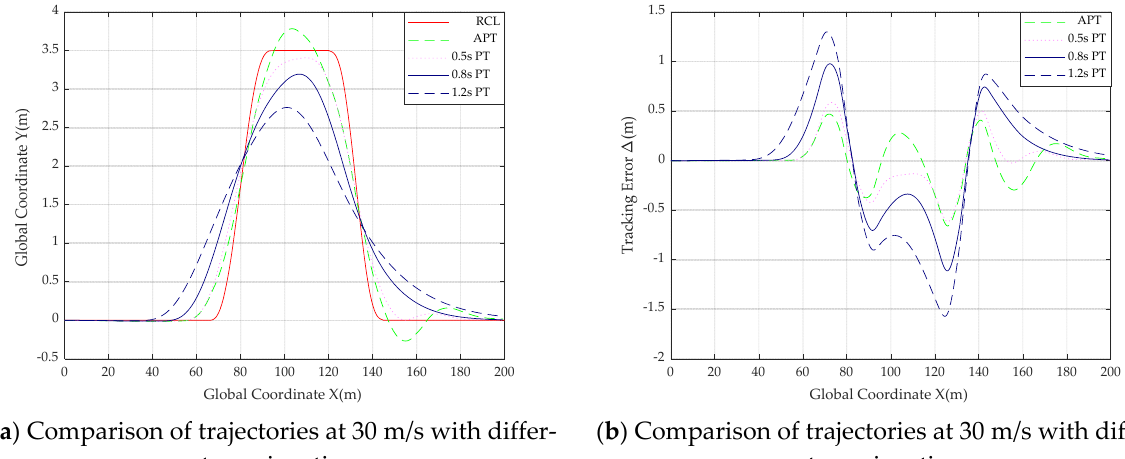
( a ) Comparison of trajectories at 25 m/s with differ ‐ ( b ) Comparison of trajectories at 25 m/s with differ ‐ ent preview times ent preview times Figure 16. Comparison of trajectories and tracking error with different preview times at 25 m/s.